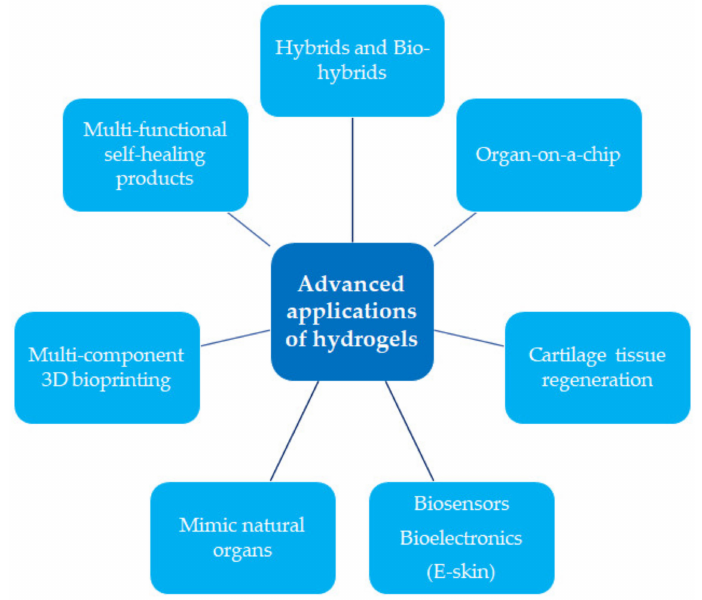
Figure 14. The advanced applications and future direction of